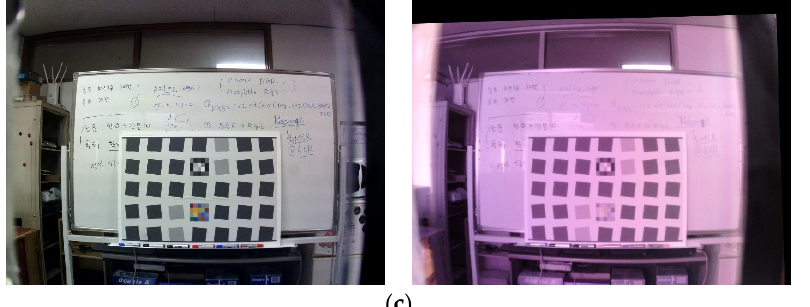
Figure 4. Aligned visible and NIR images: ( a ) visible and NIR images taken by the proposed beam splitter camera device; ( b ) example of the homography theory using the scale-invariant feature transform algorithm; and ( c ) result of the homography theory visible and NIR image alignment.